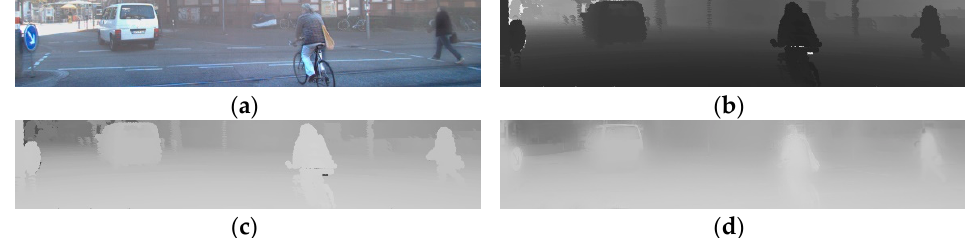
Figure 11. Refine transmission image: ( a ) hazy image; ( b ) grayscale depth image generated from